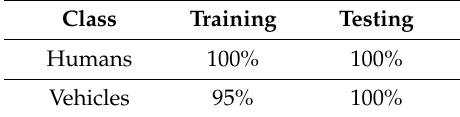
Table 1. Humans and vehicles training and testing prediction accuracy.